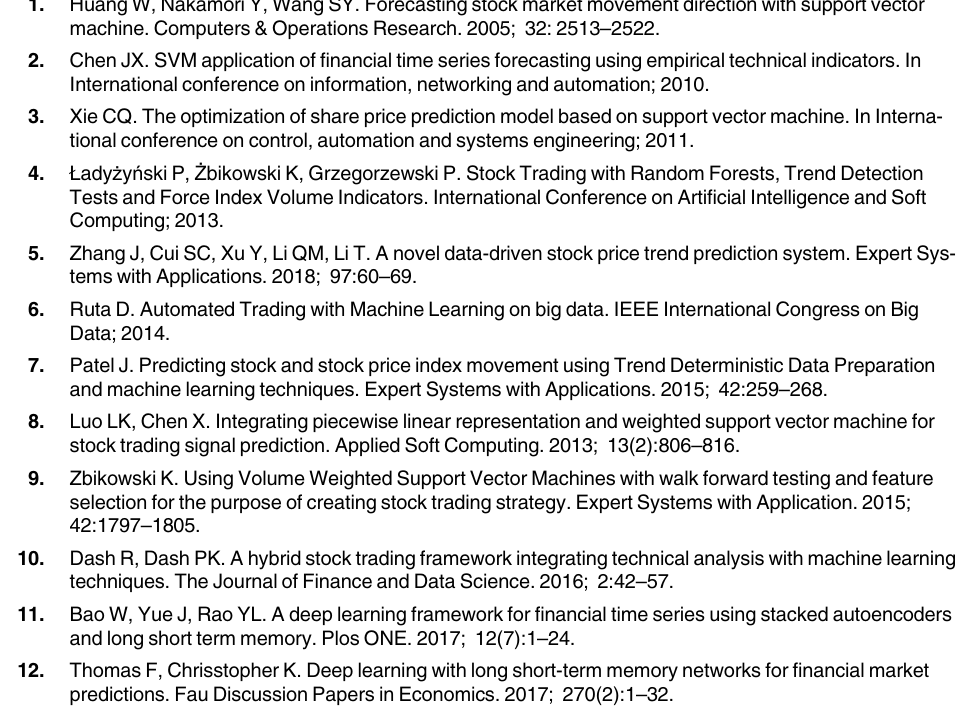
S1 Table. Features used in the machine learning algorithms. (PDF) S2 Table. The stock symbols for different industries in both SPICS and CSICS.